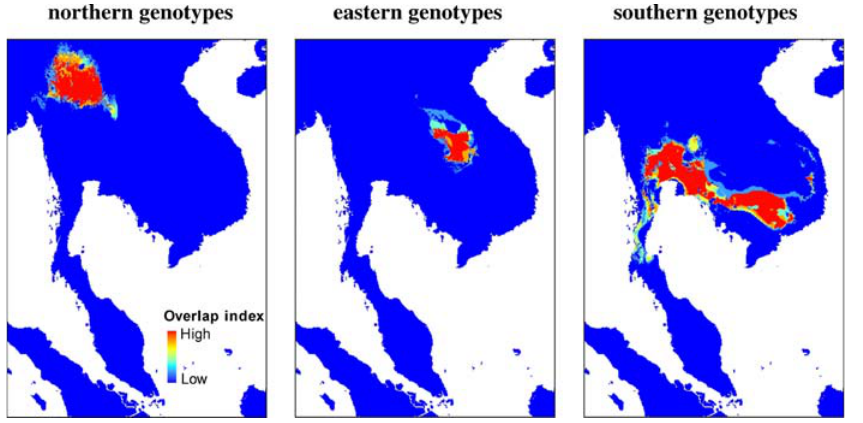
Figure 4. Predicted Distributions for Three Classes of Genotype: Northern, Eastern, and Southern Thailand The ‘‘ overlap index ’’ represents the synthesised output from 20 optimal GARP models. See Figure S2 for data sources. DOI: